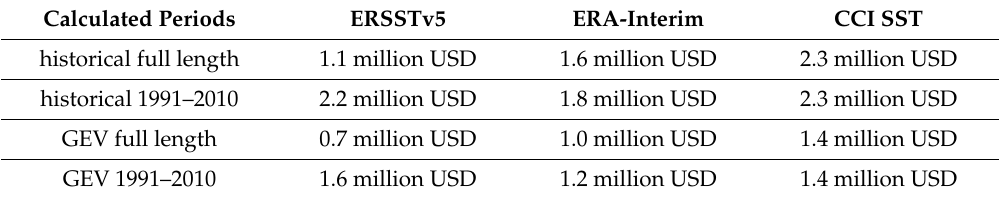
Table 6. Average annual loss in million (USD) using the three di ff erent datasets and di ff erent time